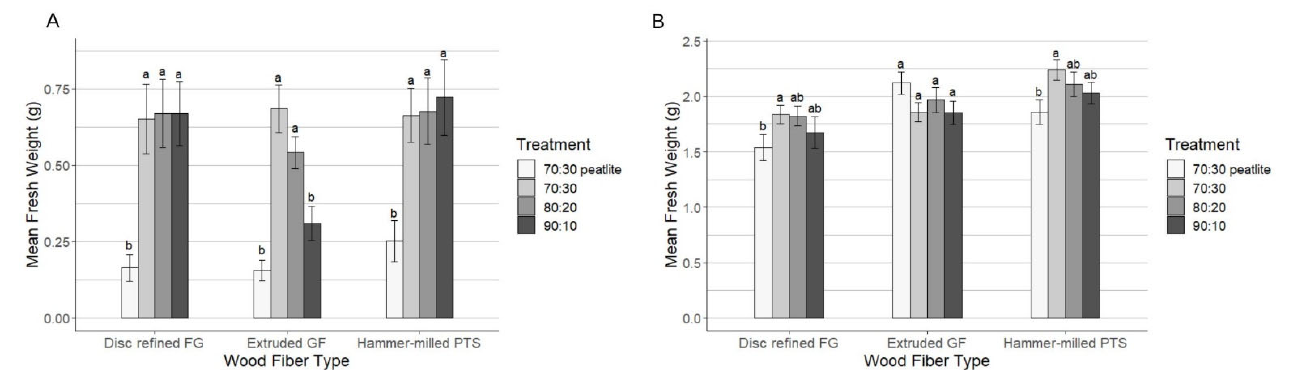
Figure 2. Mean aboveground fresh weight (g) of radish plants in ( A ) R. solani -infested and ( B ) non-infested pots 7 days post-infestation. Each wood treatment, disc-refined Forest Gold (FG), extruded GreenFibre (GF), and hammer-milled pine tree substrate (PTS), was blended with peat at four ratios. Wood treatments were tested in separate experiments, each with a 70:30 peat:perlite (peatlite) control. Within wood types, treatment means followed by the same letter are not signifi- cantly different ( α = 0.05) as determined by the Tukey HSD post hoc test ( n = 16). Errors bars represent standard error.